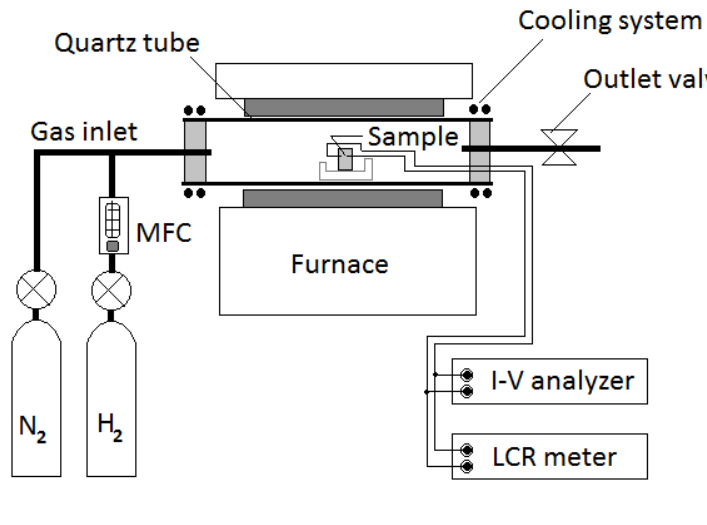
Figure 2. A set of equipment for testing hydrogen sensors.